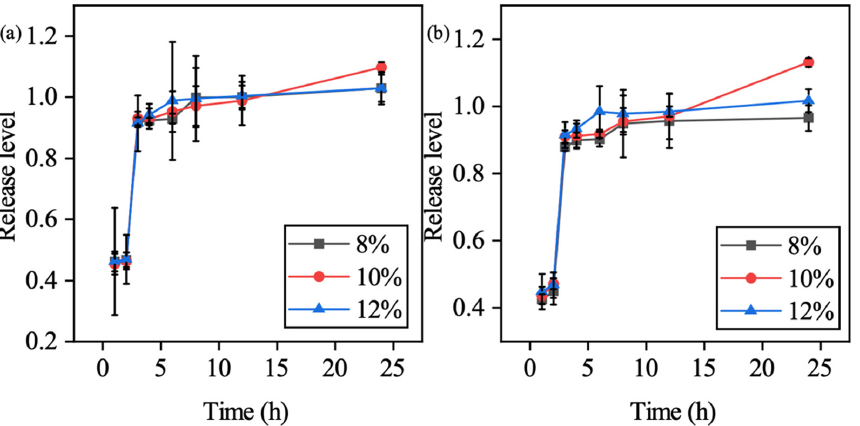
Figure 8. Cumulative release level for the standard dissolution test (pH switching at the second hour) of the non-lyophilized sample: ( a ) 504 nm, and ( b ) 530 nm.